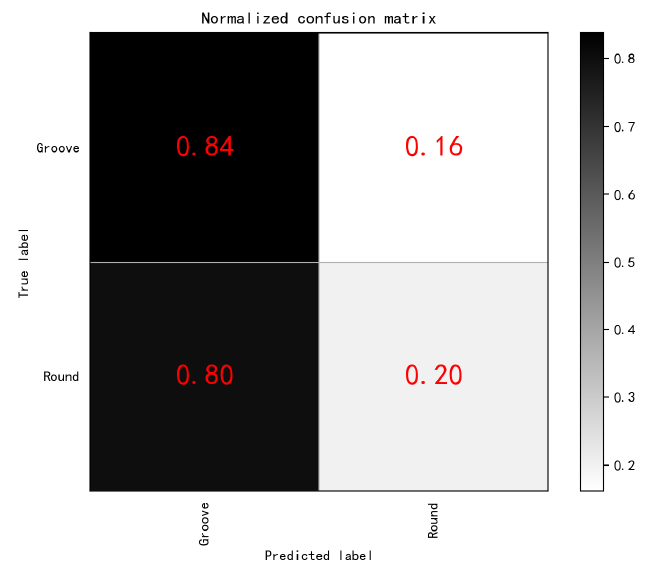
Figure 12. Naive Bayes Model for Normalized confusion matrix.